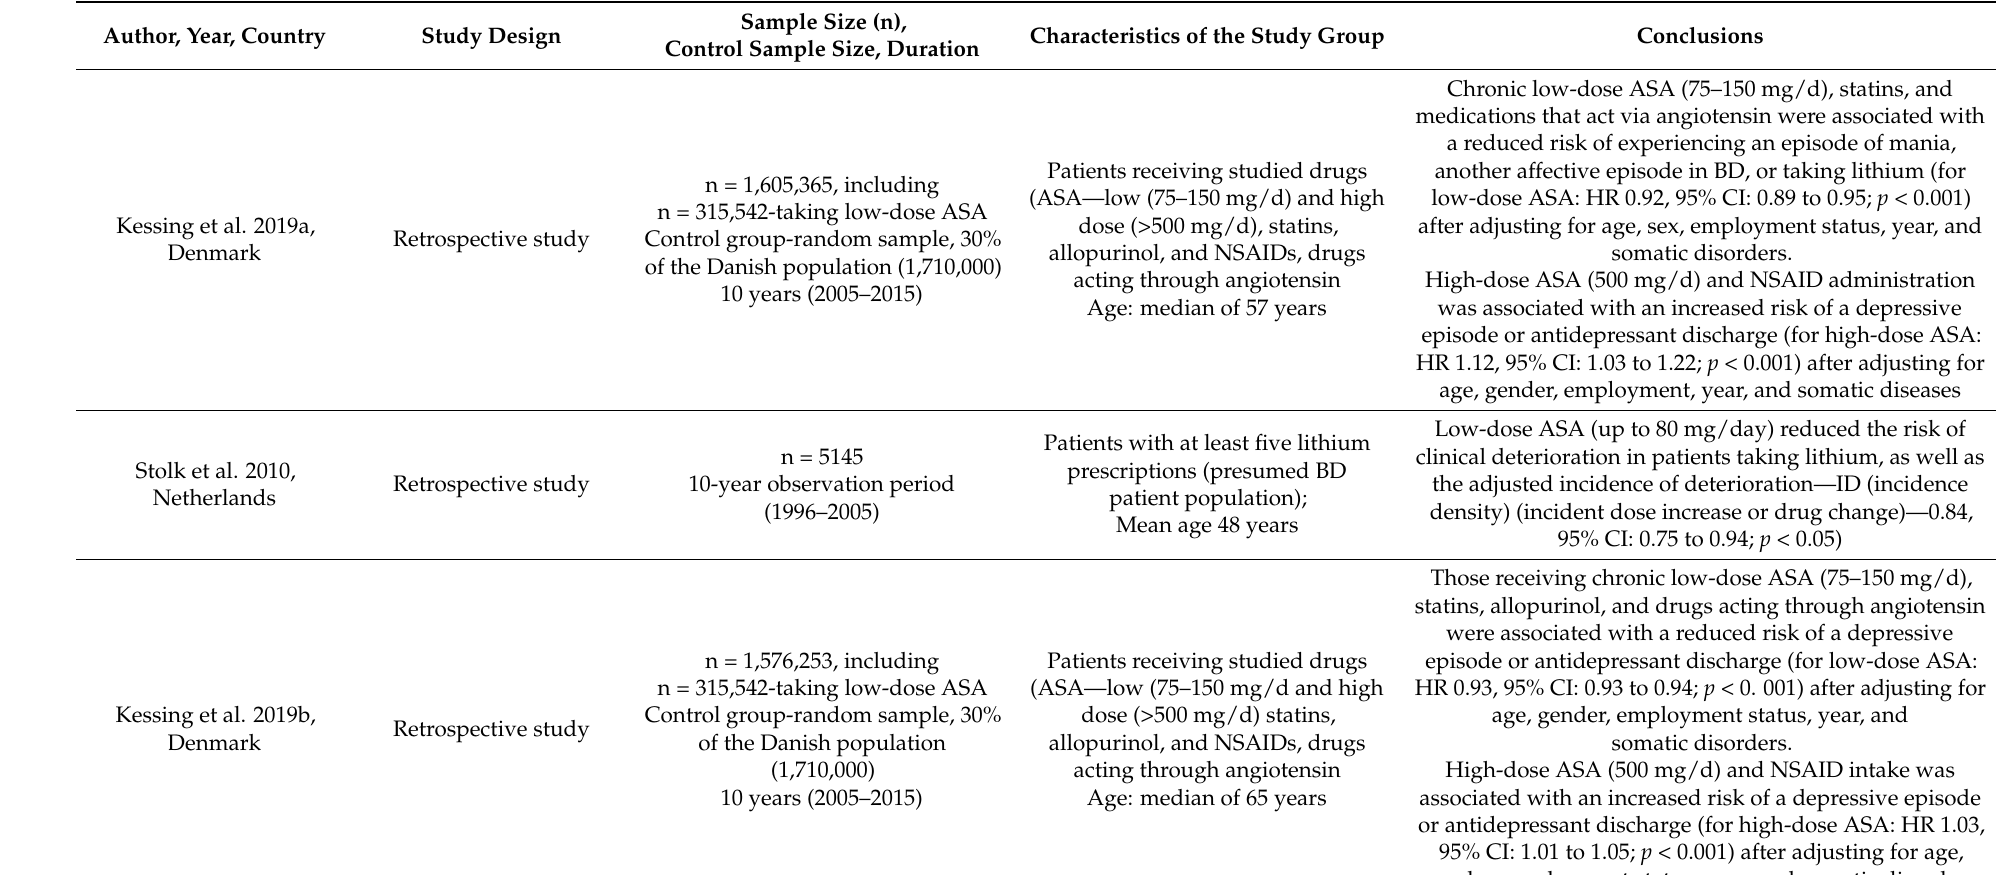
Table 3. Observational studies on the effect of ASA on mood